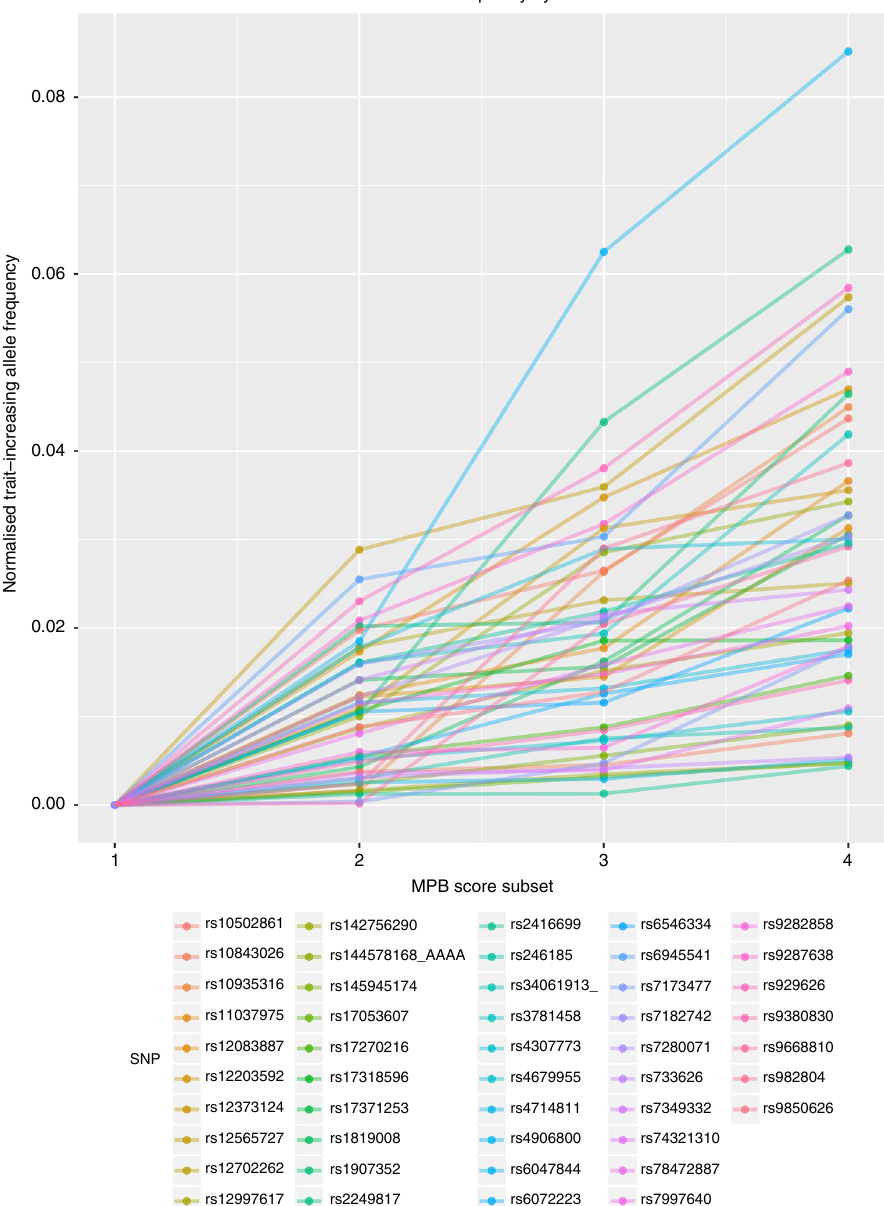
Fig. 1 Trait-increasing allele frequency by MPB score in UKB for 47 genome-wide signi fi cant GWAS loci identi fi ed in refs. 2 – 6,10 . For each of the 47 loci, the trait-increasing allele frequency in the UK Biobank sample is given on the y -axis, as a deviation from its frequency for men with a MPB score of 1. The x -axis labels represent the observed MPB categories in the UK Biobank